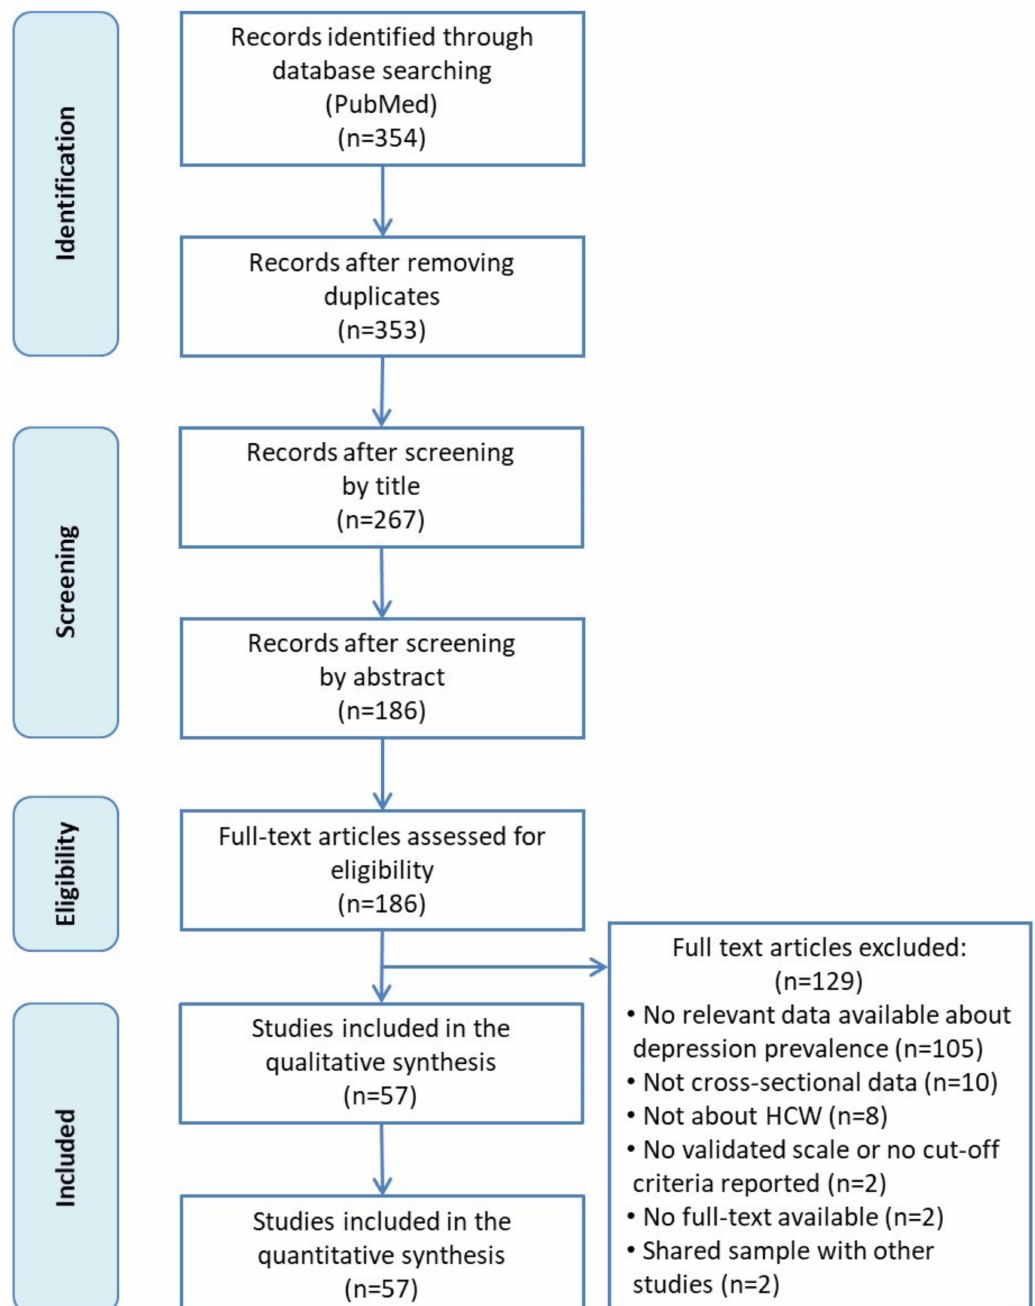
Figure 1. Flowchart of the study